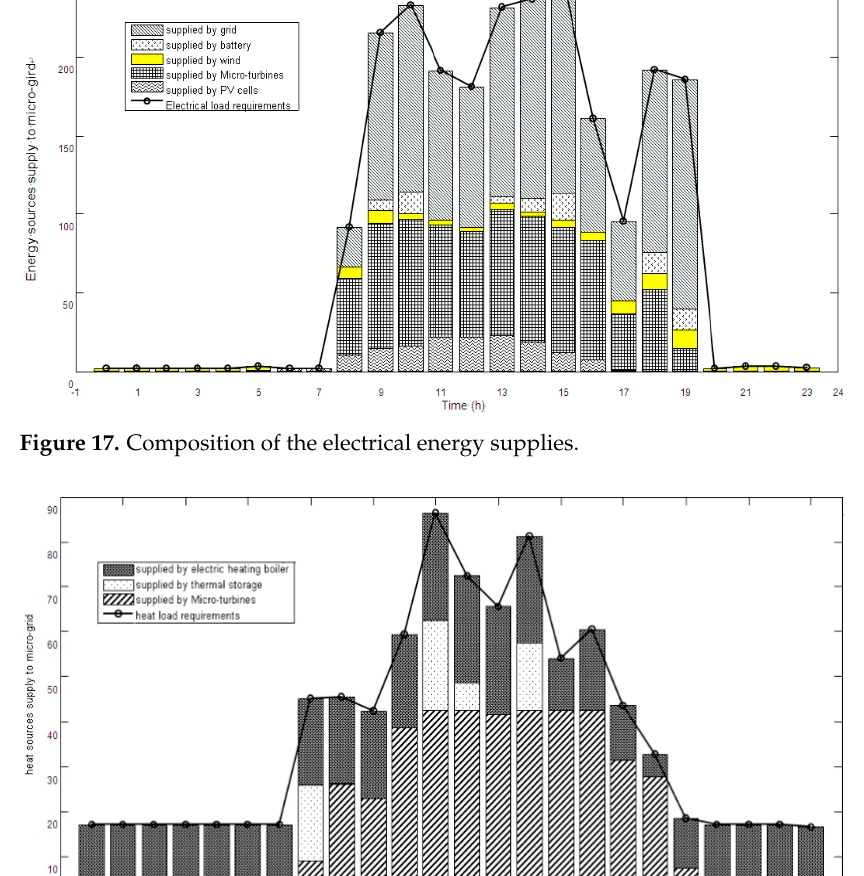
Figure 16. The remaining heat in thermal storage.